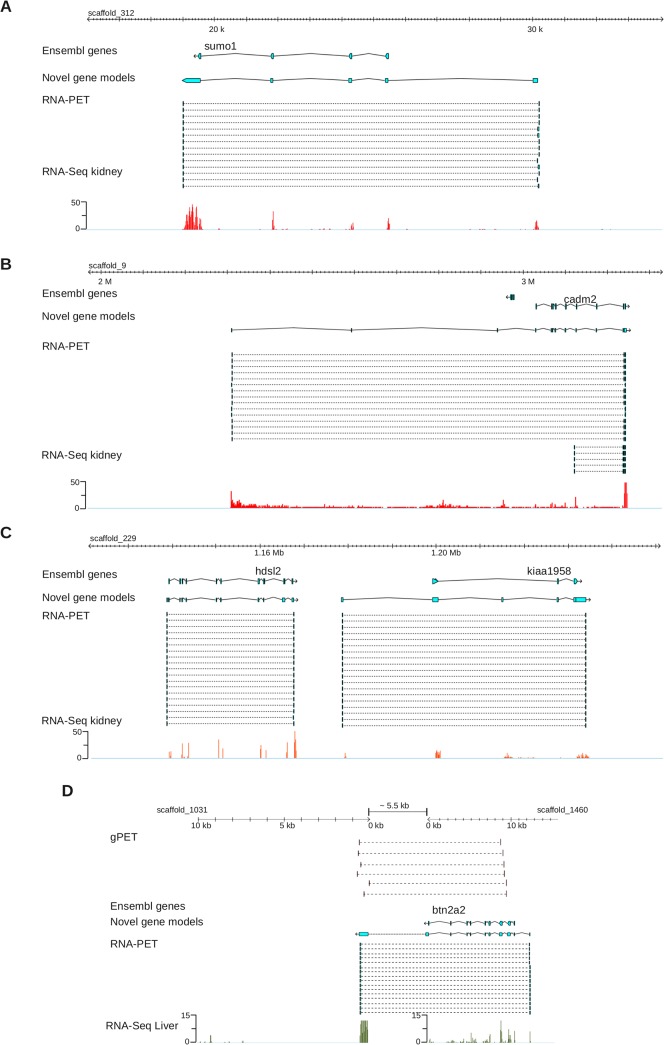
Examples of genome annotation improvements.Track order: Ensembl models, RNA-PET based models, RNA-PET ditags and RNA-Seq reads density. A, B, C: sumo1, cadm2 and kiaa1958 loci. D: Un-annotated gene split over scaffold_1031 and scaffold_1460.